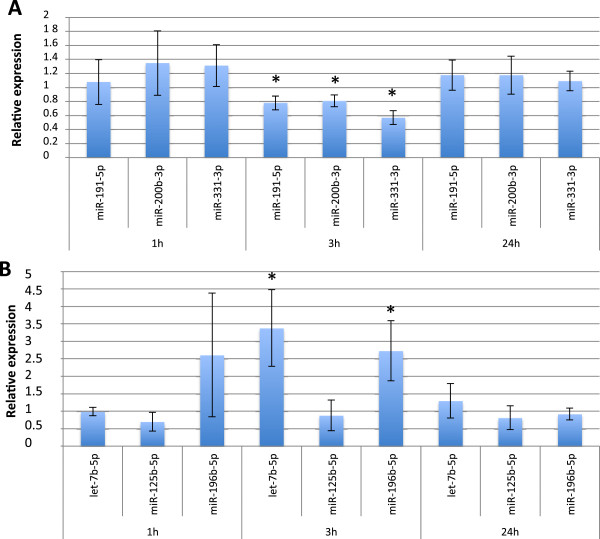
Confirmation of TLDA data by individual quantitative real-time PCR (qRT-PCR). Validation of TLDA data by qRT-PCR in irradiated (6Gy) vs non-irradiated proliferating (A) or differentiated (B) keratinocytes at 1, 3 and 24 hours post-IR. Values are mean fold changes +/− SD of independent experiments performed in triplicate on keratinocytes from 3 different donors (bilateral paired t-test : *p≤0.05).